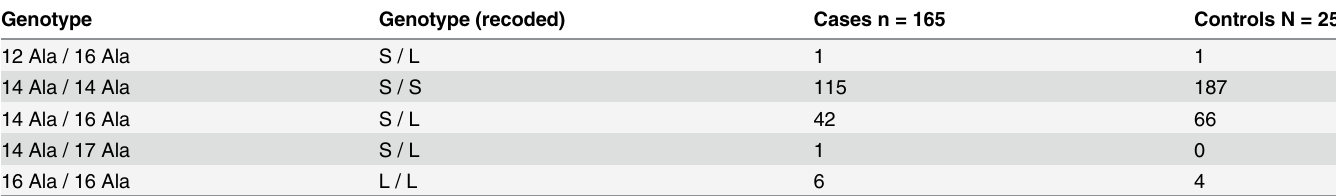
Table 5. Observed frequencies of FOXE1 multi-allelic poly-alanine tract alleles (rs71369530) in the Polynesian population.